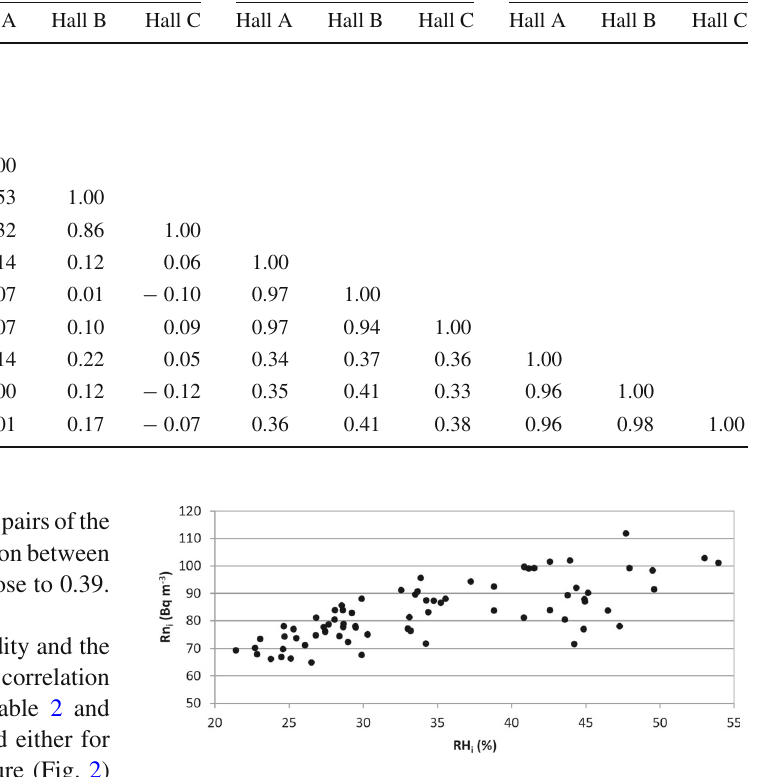
Fig. 3 Monthly average of the temperature in the hall B (left) and hall C (right) from January 2013 to December 2018. The sharp increase of the temperature due to ArDM experiment (see text) is very attenuated in the hall B and it is almost imperceptible in the hall C Table 2 Values of Pearson correlation coefficient r (2013–18) for all pairs of the measured monthly averaged parameters inside the LSC Radon Temperature Pressure Relative humidity